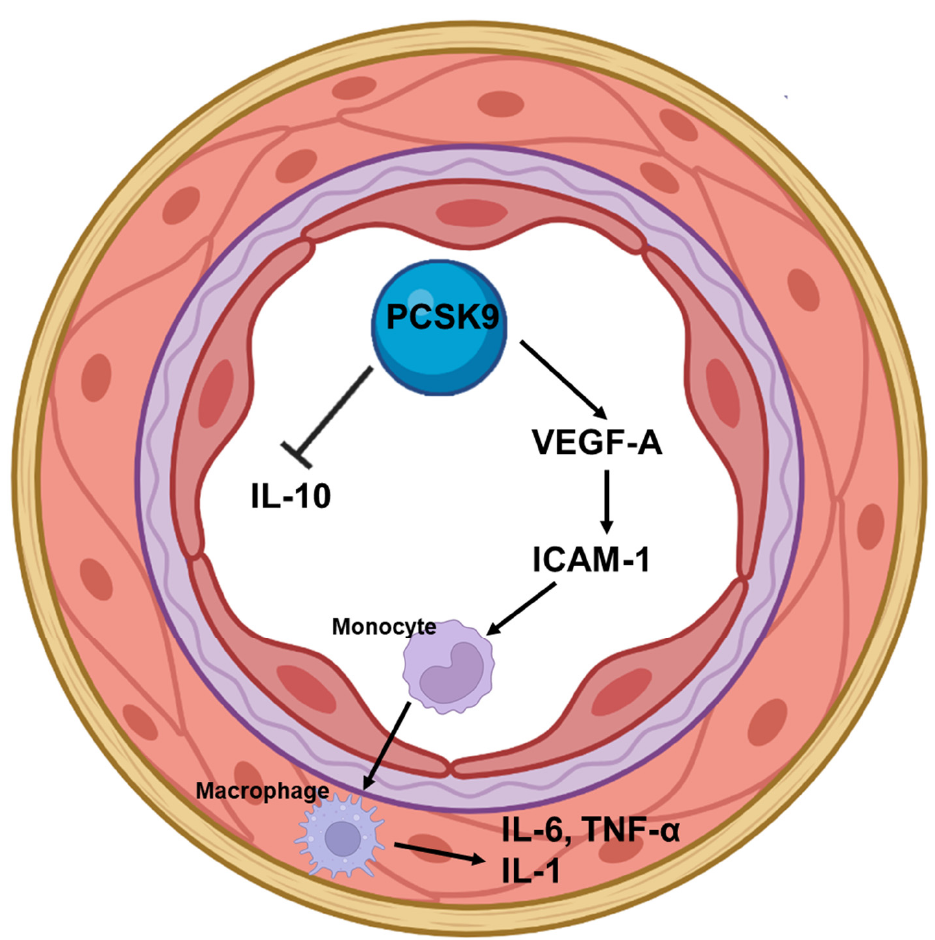
Figure 1. The role of PCSK9 in inflammation process. PCSK9 induces the expression of VEGF-A and ICAM-1 and, consequently, activates endothelial cells and stimulates monocyte/macrophage migra- tion. The cascade promotes an inflammatory state and the progression of the atherosclerotic process. On the other hand, anti-inflammatory cytokines such as IL-10 attenuate the inflammatory response. PCSK9, proprotein convertase subtilisin/kexin type 9; VEGF-A, vascular endothelial growth factor A; ICAM-1, intracellular adhesion molecule-1; IL, interleukin; TNF- α , tumor necrosis factor- α .